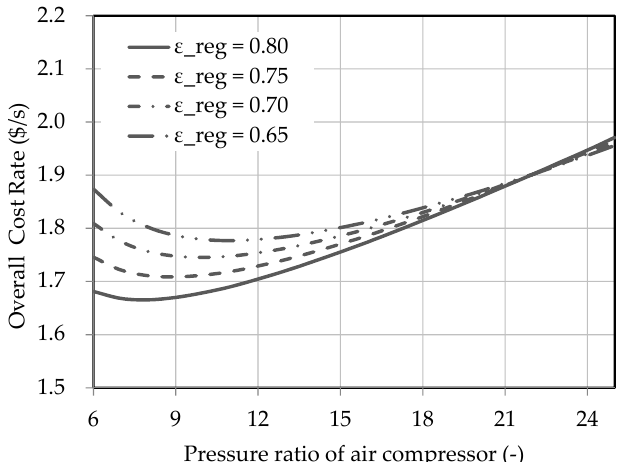
Figure 5. Overall cost rates for the gas turbine regenerative cycle for various regenerator effectiveness. The efficiencies of the compressor and turbine were fixed at 92.9% and 92.6%, respectively, which were the efficiencies suggested by